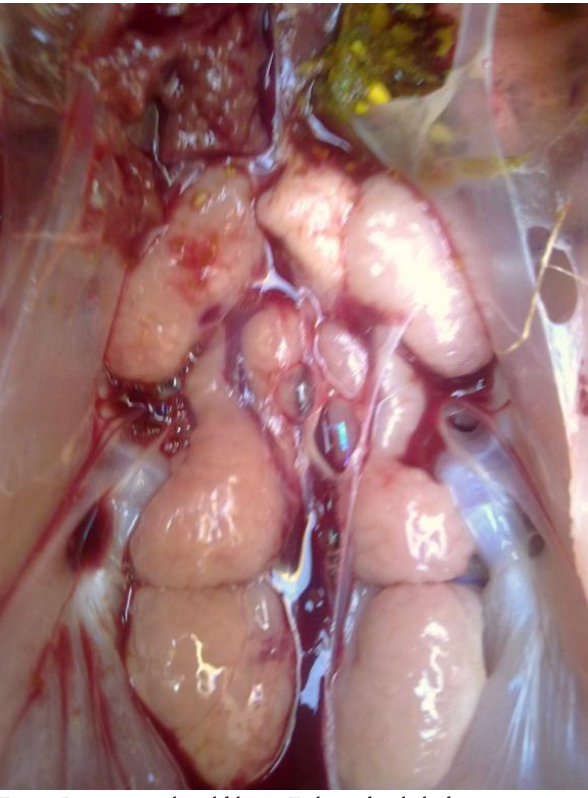
Fig. 2. Live 20 weeks-old layer. Enlarged pale